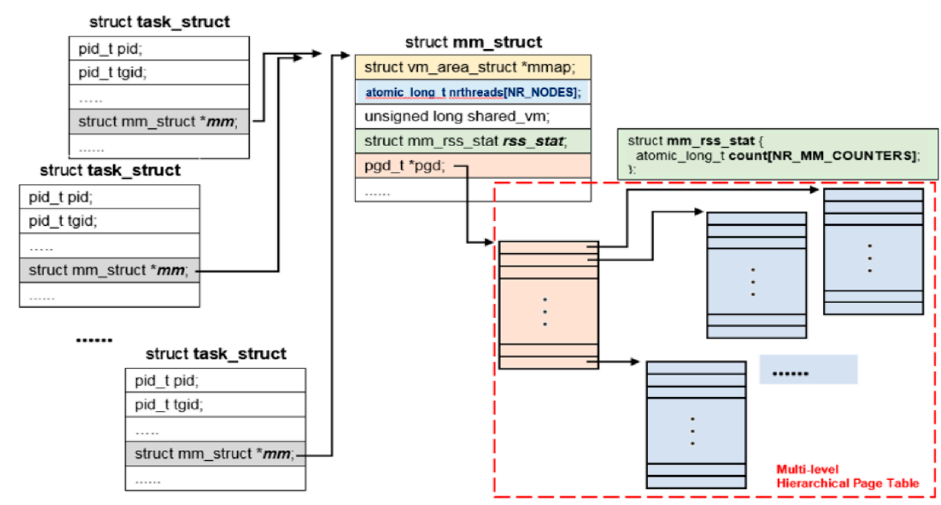
Figure 8. Tasks in a thread group share memory management